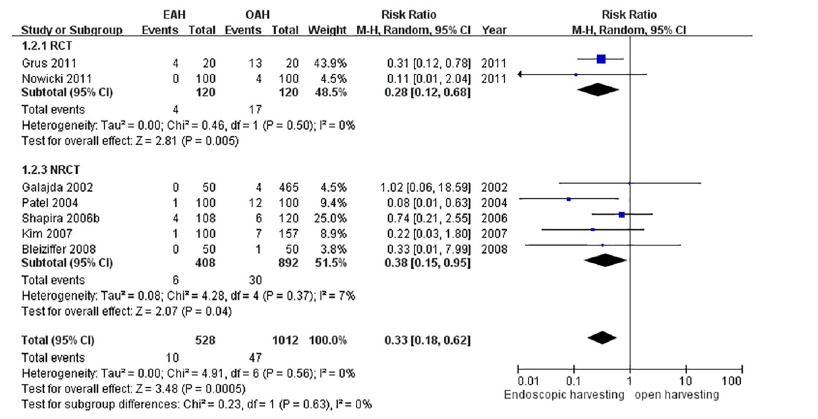
Fig 4. Forest plot for wound